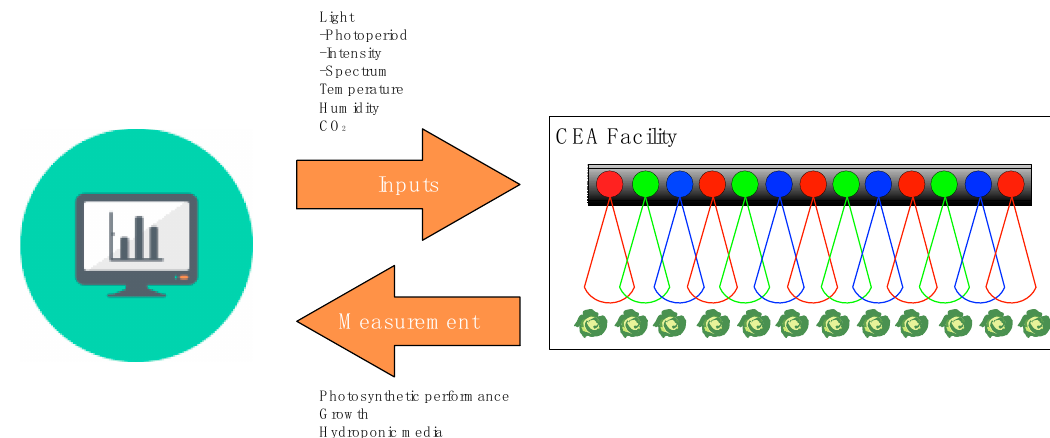
Figure 2. Controlled environment agriculture enables precise control and monitoring of the growth environments. Light properties that can be varied include photoperiod (daylength), intensity, and quality. These factors interact with other variables (including temperature, humidity, and CO 2 concentration), which are not considered in this review. Future progress in this field will be accelerated by the improved measurement of photosynthetic performance, crop quality indicators, and nutritional media composition, which could be combined with machine learning to further improve lighting regimes.